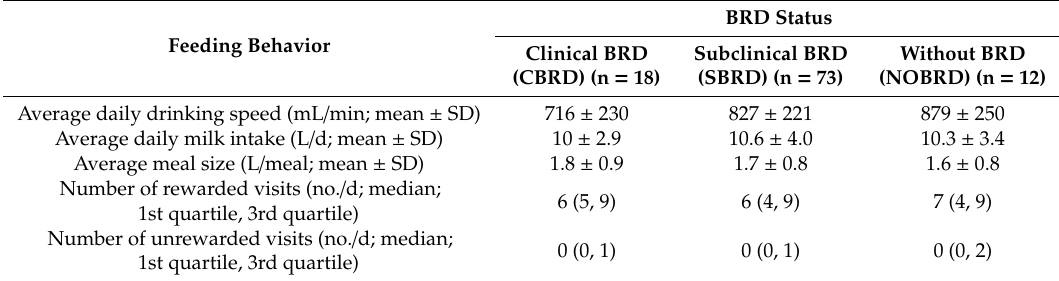
Table 2. Raw values for feeding behaviors, by Bovine Respiratory Disease (BRD) status, over the 3 d before, the d of, and the 3 d after BRD detection. Calves were enrolled in the study at 21 ± 6 (mean ± SD) d of age and underwent twice weekly health